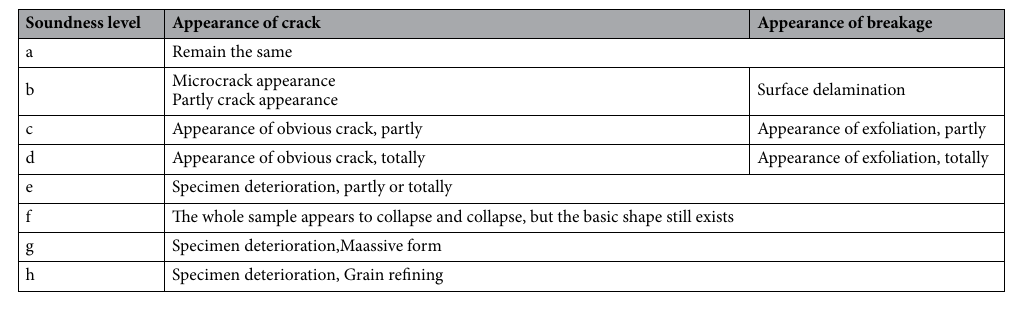
Table 8. Soundness evaluation